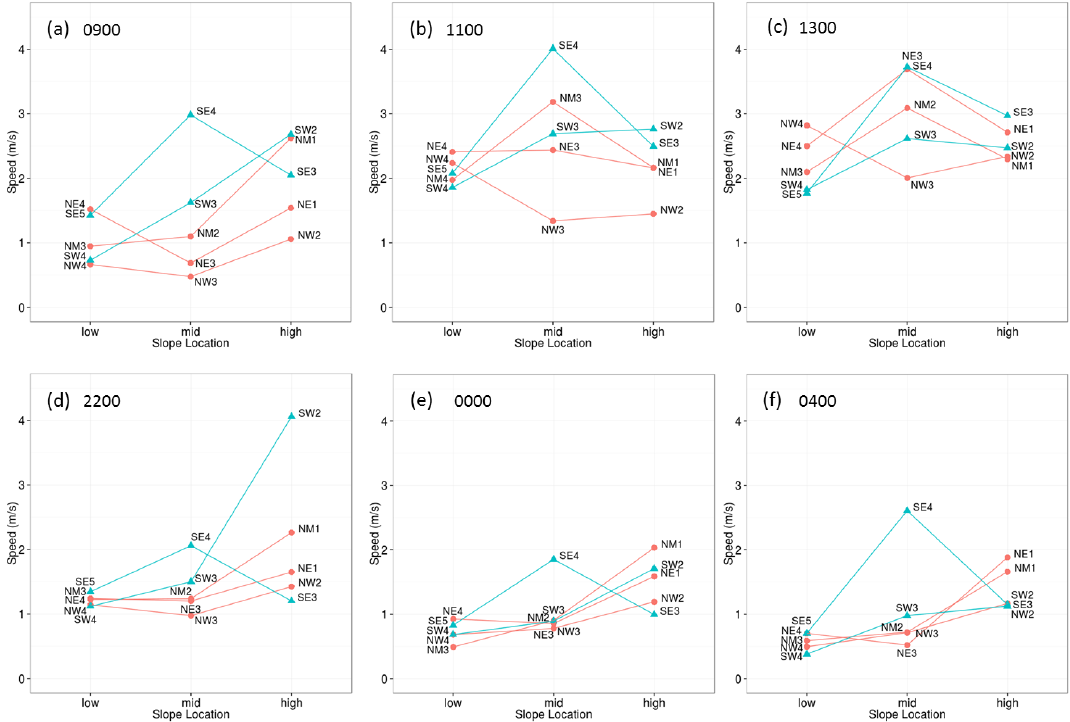
Figure 13. Average wind speeds for sensors at three slope locations (low, mid, and high) along five transects during 3h of the upslope (a–c) and downslope (d–f) flow regimes at the Salmon River Canyon site. Blue and red lines are transects on the southern and northern sides of the river, respectively.